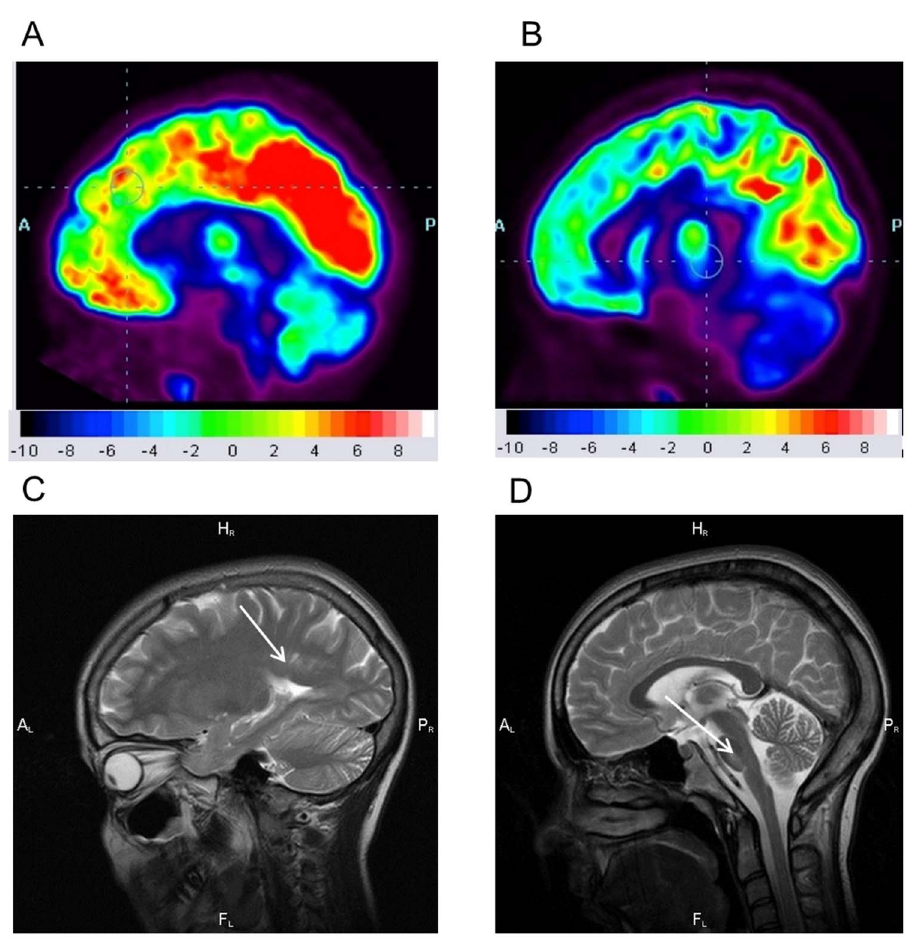
Fig. 2. Differences in FDG uptake in PET-CT scans of the brain between a healthy child (a) and WFS6 patient (b) and small lesions in MRI scans in WFS6 patient in the paraventricular white matter (c) and brain stem (d).